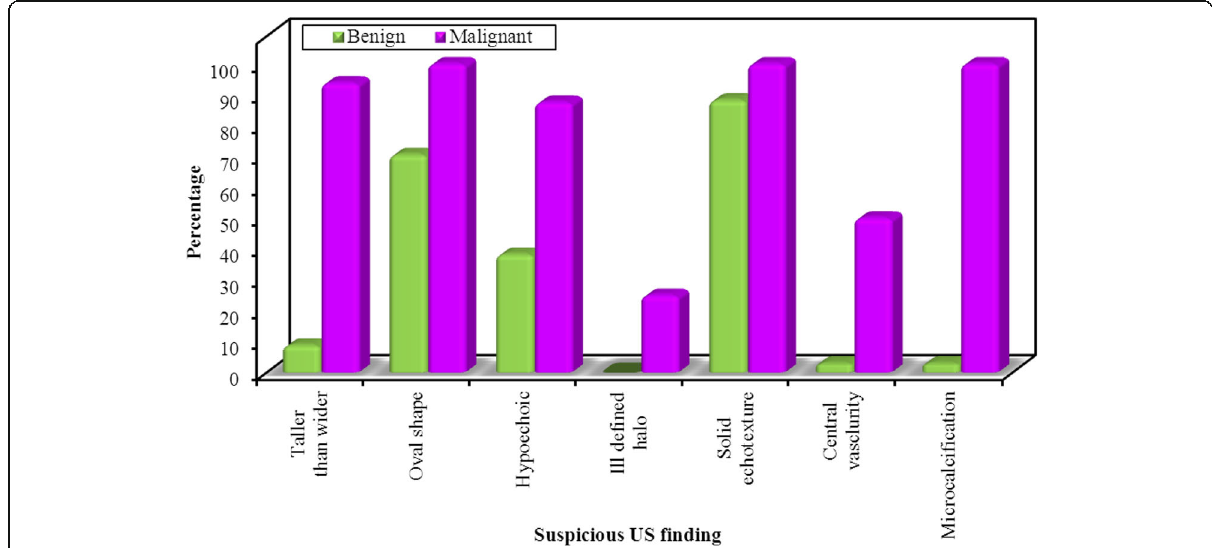
Fig. 2 Distribution of suspicious US features in thyroid nodules